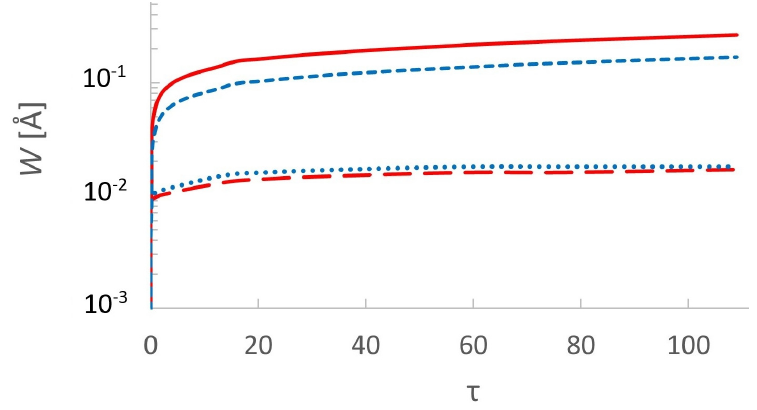
Figure 3. Same as in Figure 2 but for the atmosphere of a DB white dwarf. The atmosphere model from [37] with parameters T ef f = 25,000 K and log g =